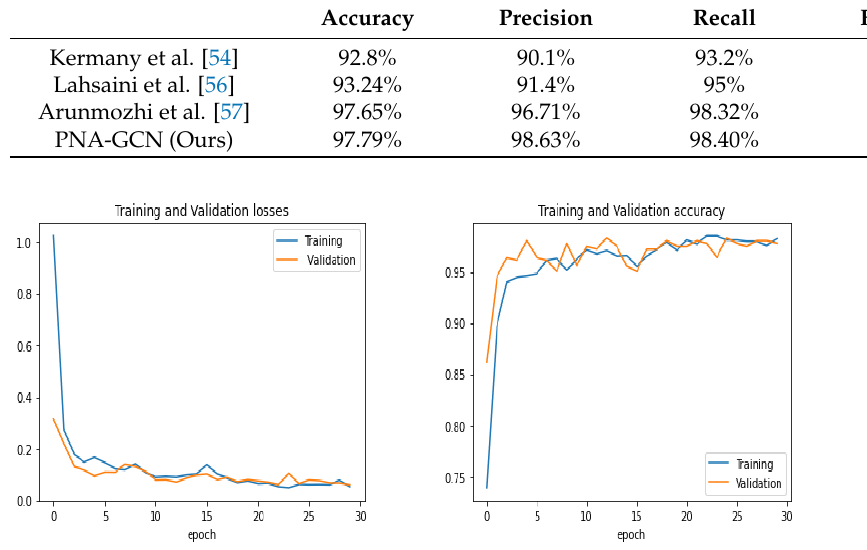
Figure 7. Training and validation performance.